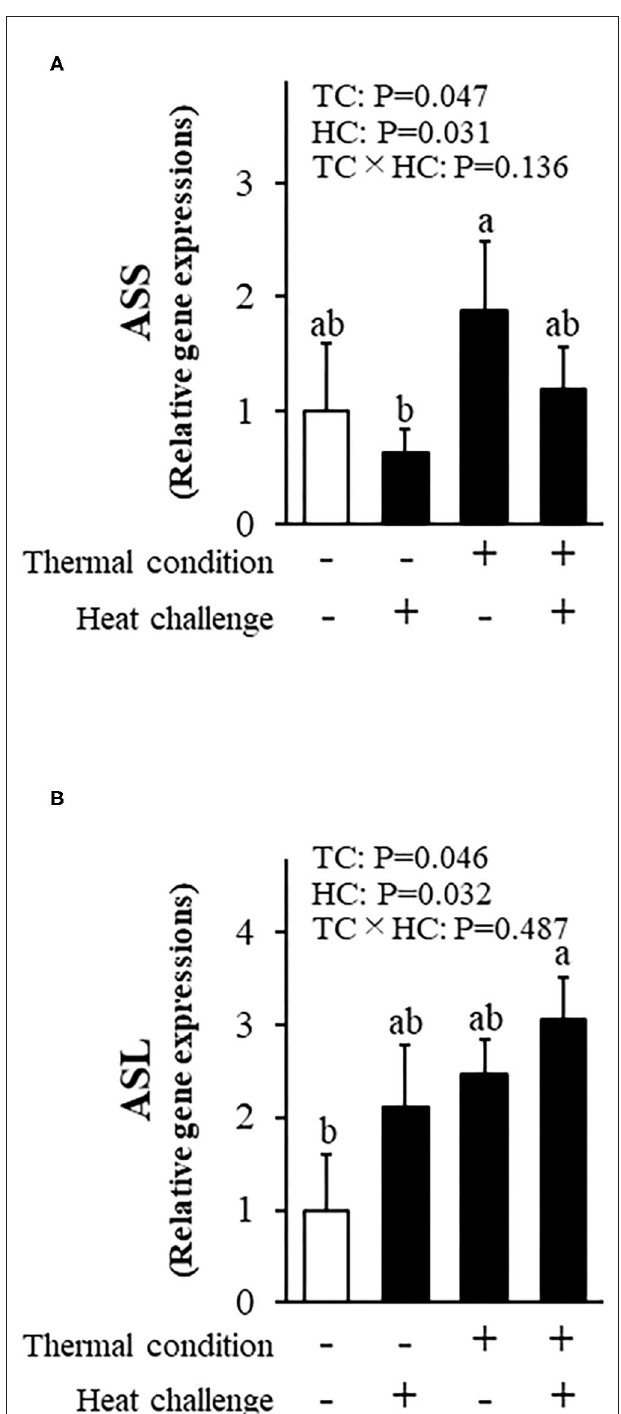
FIGURE 6 | Effect of thermal conditioning on hepatic gene expressions in chicks. (A) argininosuccinate synthase (ASS), (B) argininosuccinate lyase (ASL). TC, thermal condition; HC, heat challenge. Data were expressed as means ± SEM. The number of chickens in each group was n = 8. + : treatment, –: non-treatment. There is a significant difference between different